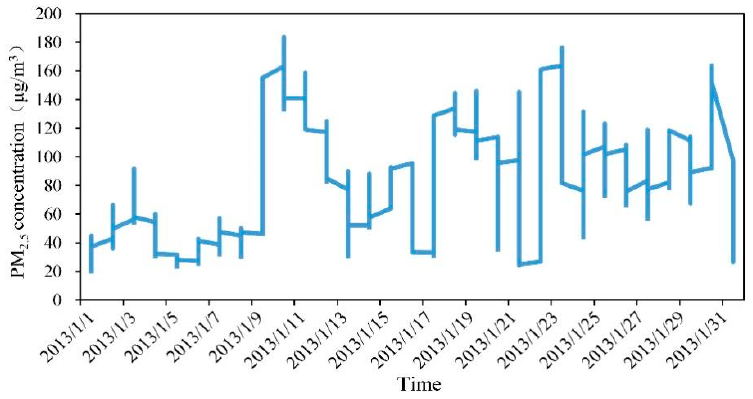
Figure 8. Line graph of PM 2.5 data at monitoring stations in January 2013.